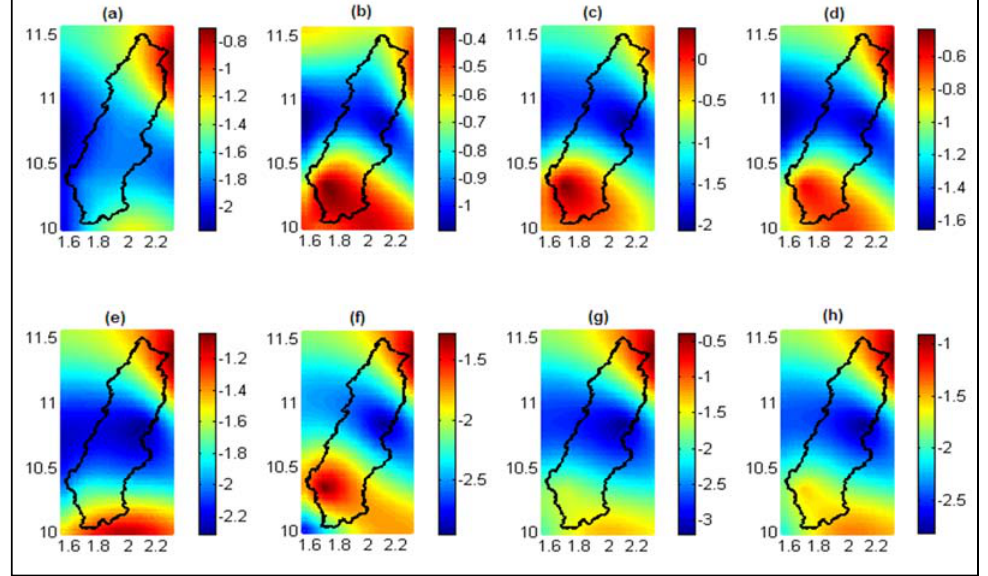
Figure 7 . Changes in the end of the rainy season (%) compared to the reference period a : RCP4.5 ‐ 2011–2040; b : RCP4.5 ‐ 2041–2070; c : RCP4.5 ‐ 2071–2100; d : RCP4.5 ‐ 2011–2100; e : RCP8.5 ‐ 2011–2040; f